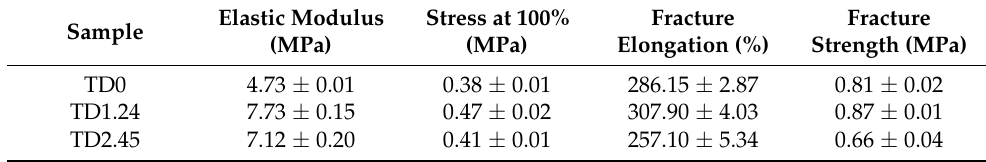
Table 2. Tensile properties of typical tie-coating samples.